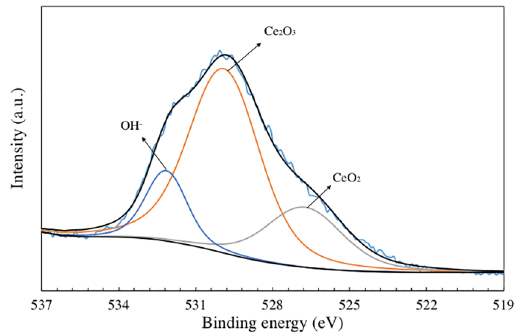
Figure 8. Representative XPS core level for the O1s region of the conversion film obtained after 60 s of immersion.